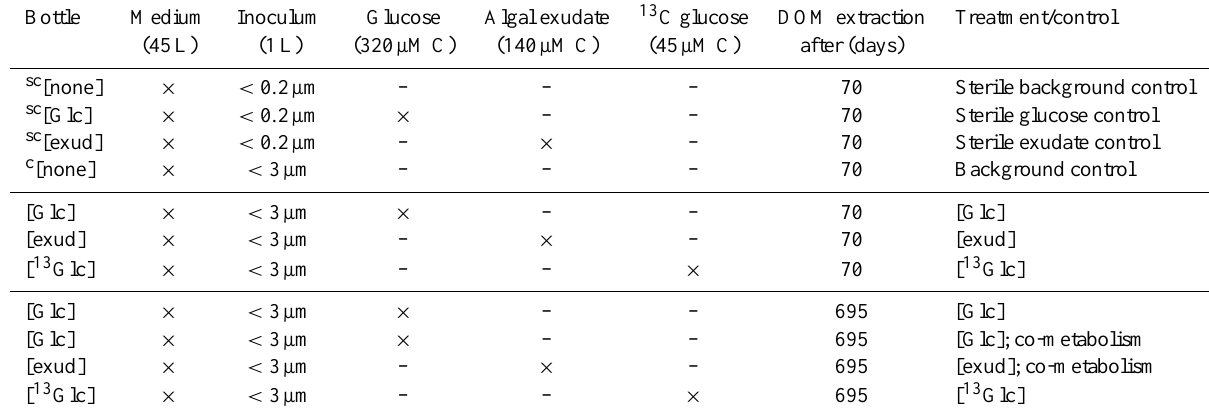
Table 1. Experimental setup: three different substrates were incubated in 50L glass bottles for 70, 695 and 734 days. Bottle